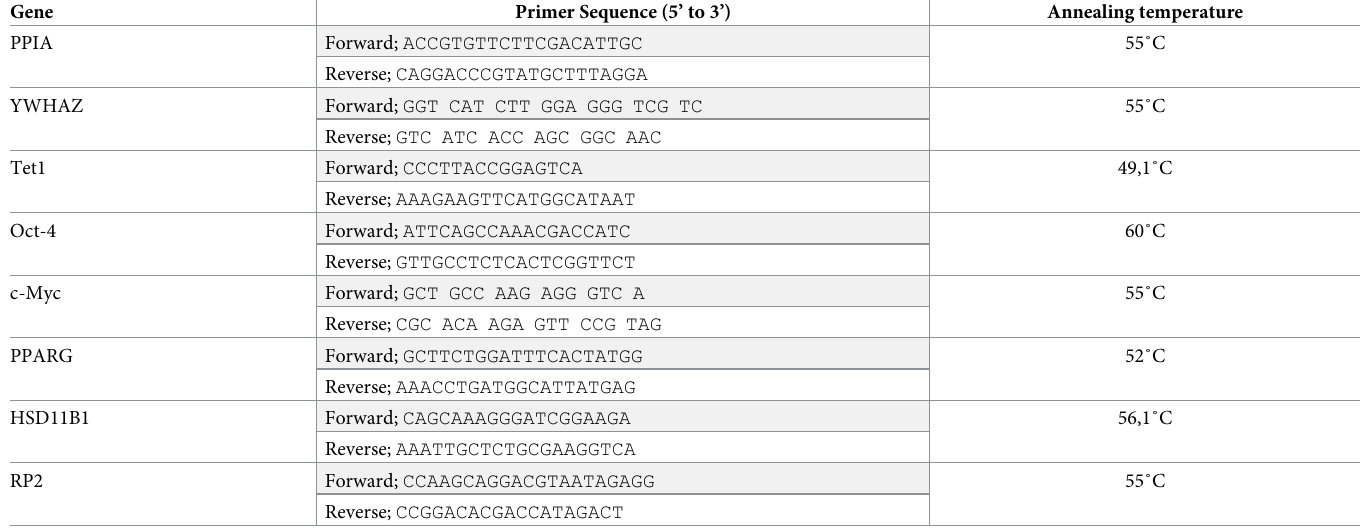
Table 1. Primers used for RT-PCR